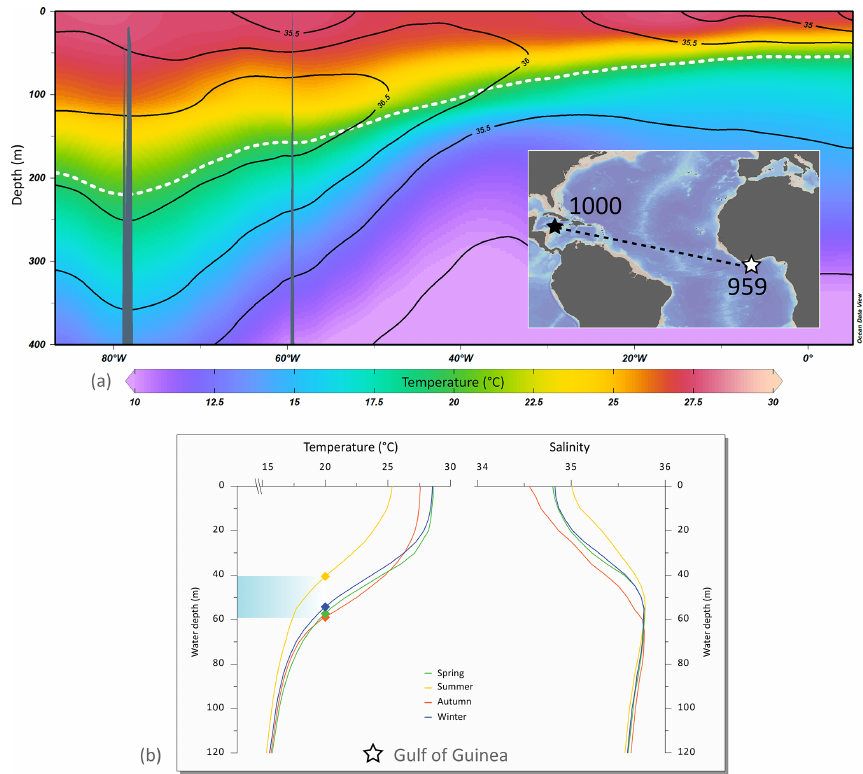
Figure 2. (a) Upper ocean temperature (shaded contours; Locarnini et al., 2013) and salinity (black contours; Zweng et al., 2013) profiles across the black stippled line (see map) between Site 1000 and Site 959. The white stippled line shows the 20 ◦ C isotherm depth. Cross section generated with Ocean Data View (Schlitzer, 2020). (b) Seasonal vertical temperature and salinity profiles in the Gulf of Guinea (2.5 ◦ N, 3.5 ◦ W; Locarnini et al., 2013; Zweng et al., 2013). Symbols (left panel) mark the 20 ◦ C isotherm depth, which varies seasonally between ∼ 40–60m.